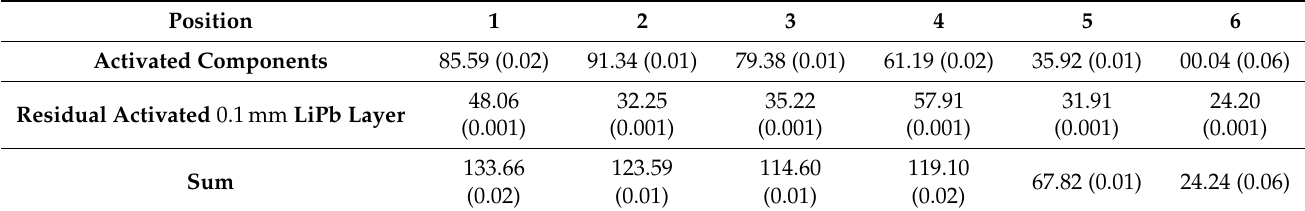
Table 4. Breakdown of C4RC SDDR [ µ Sv/h] (calculated relative error) at 12 days following Short sce-